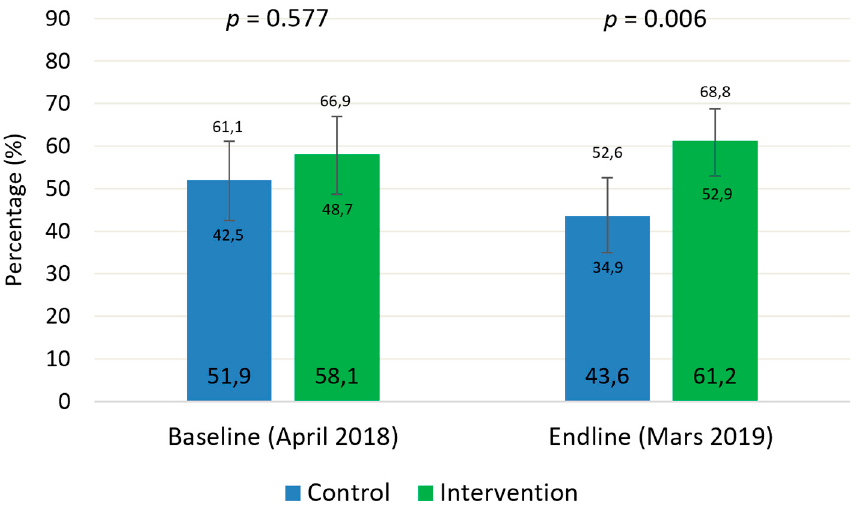
Figure 1. Coverage of severe acute malnutrition treatment in the study groups before and after the intervention.